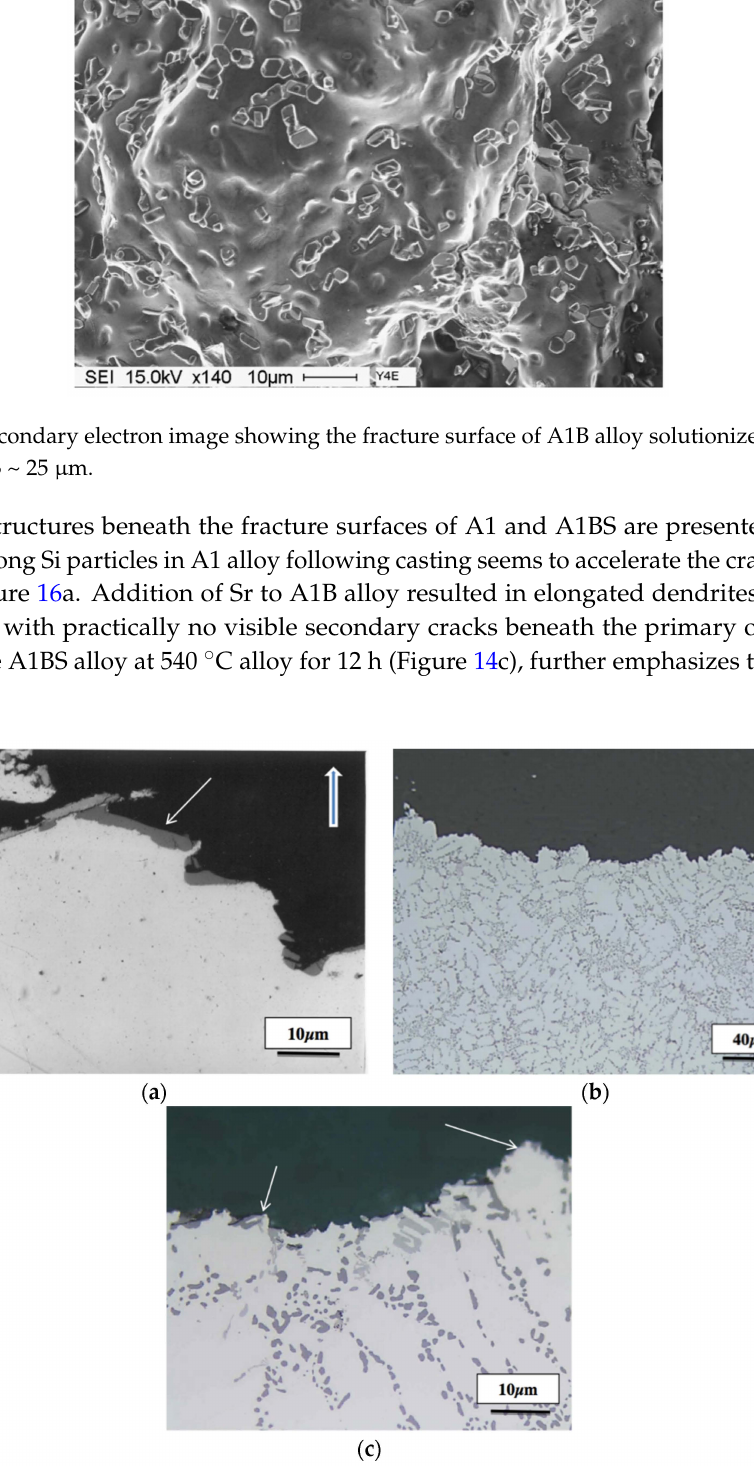
Figure 16. Microstructure beneath the fracture surface of: ( a ) A1alloy-as cast; ( b ) A1BS alloy-as cast; ( c ) A1BS alloy after solutionizing at 540 ˝ C for 12 h. The thick white arrow in ( a ) indicates the tensile direction, whereas thin arrows in ( a ) and ( c ) show the tips of the dendrites, DAS ~ 25 µ